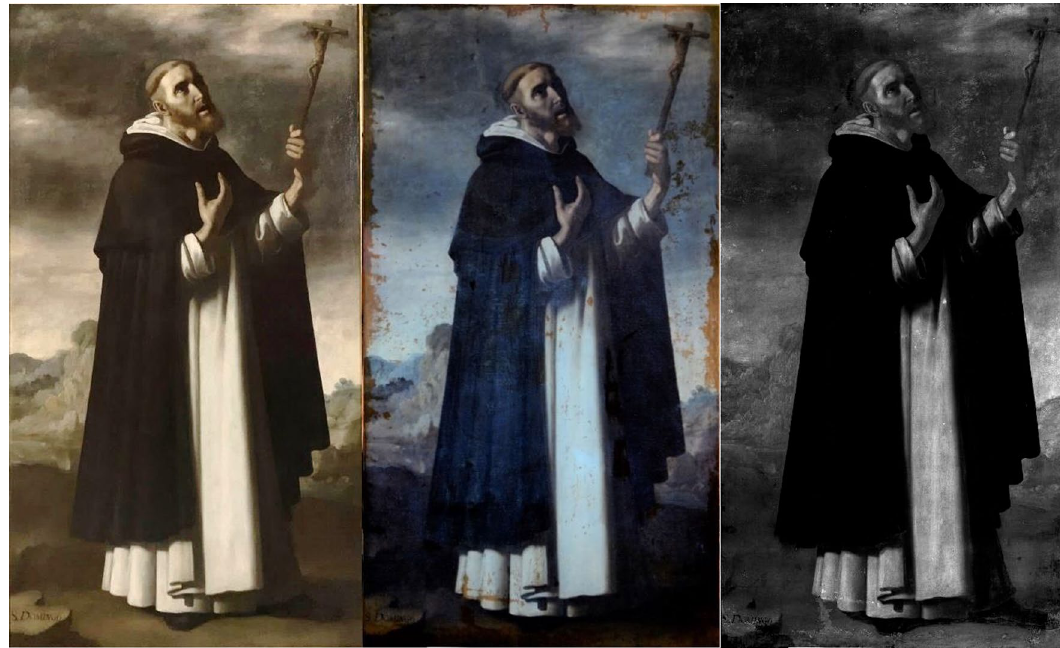
Figure 3. Painting of Saint Dominic of Guzman ( SD ) in visible (left), UV (centre), and IR (right) light.